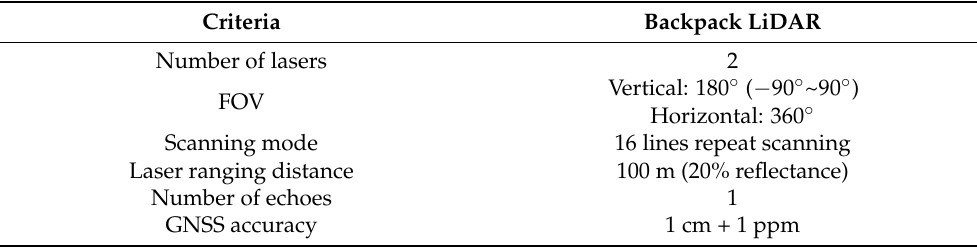
Table 2. Specifications of the LiBackpack